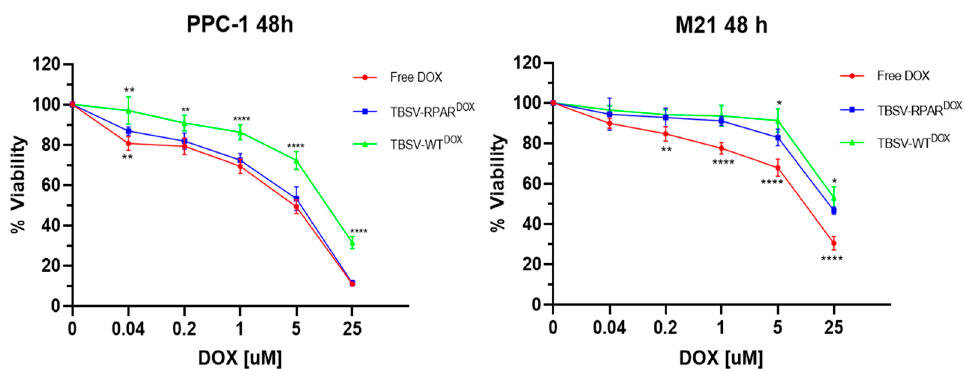
Figure 6. Cytotoxic e ff ect of drug-loaded TBSV-NPs. Viability of PPC-1 and M21 cells after 48 h of incubation with di ff erent concentrations of free DOX or DOX-loaded TBSV-NPs was estimated by MTT assay. Data are presented as mean ± SD of biological replicates, n = 6. * p = 0.018; ** p = 0.0051; **** p < 0.0001. Student’s t -test (TBSV-RPAR DOX compared with TBSV-WT DOX and TBSV-RPAR DOX compared with free DOX).